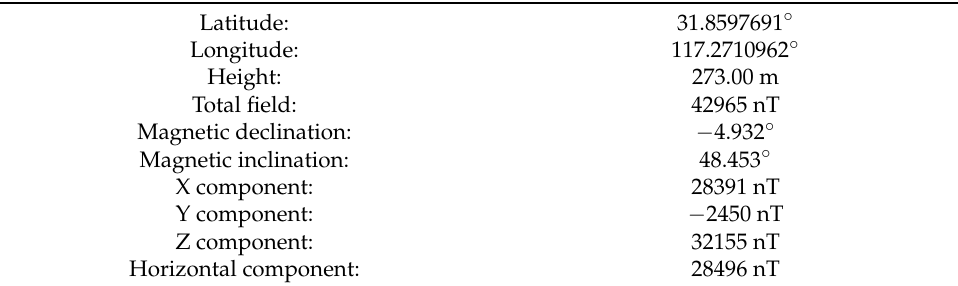
Table 1. Local magnetic field information.